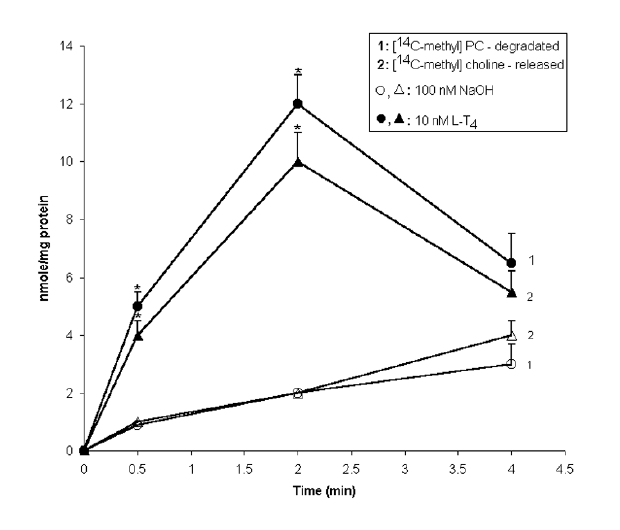
Effect of L-T 4 on [ 14 C-methyl]PC metabolism in iso- lated liver cell plasma membranes. [ 14 C-methyl]PC metabolism in isolated plasma membranes was investigated as described in "Materials and Methods". Results are mean ± S.E. of four individual experiments. * P < 0.05 vs.